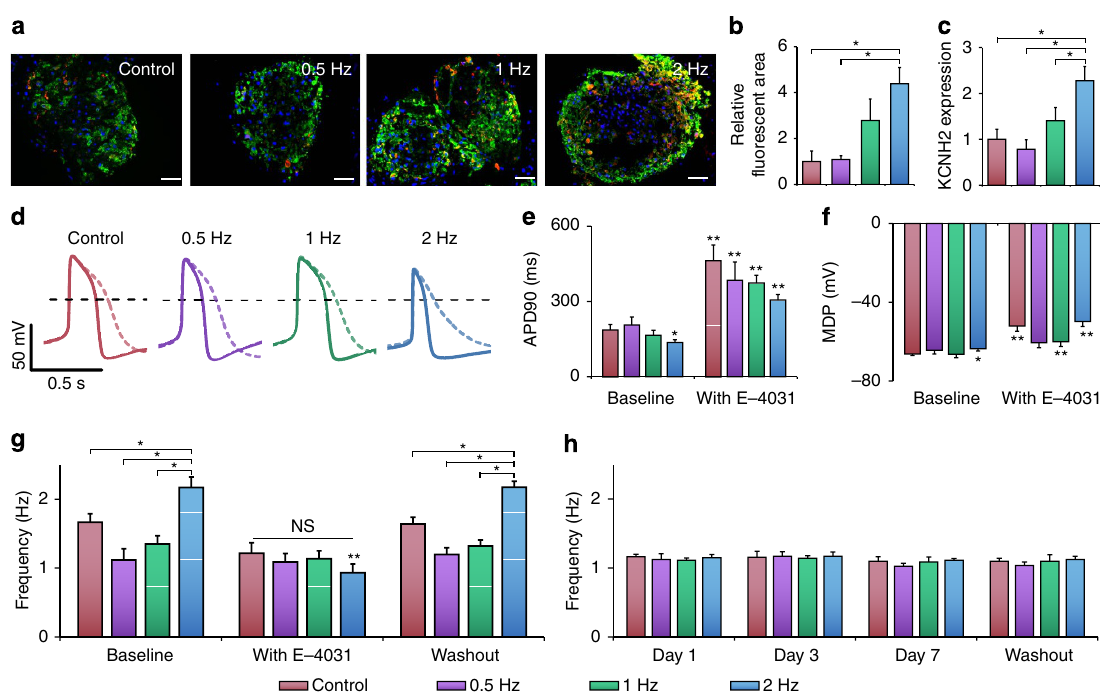
Figure 3 | Conditioning of the beating frequency by electrical stimulation is mediated by KCNH2 . ( a , b ) Immunostains of troponin (green) and hERG (red), counterstained with 4,6-diamidino-2-phenylindole (DAPI, blue); scale bar, 50 m m. Frequency-dependent increases in Troponin and hERG ( n ¼ 3, P o 0.05, one-way ANOVA with post hoc Tukey test). ( c ) qPCR of KCNH2 confirms the upregulation with stimulation (average ± s.e.m. of fold change). *Statistically significant differences between the 2-Hz group and the 1-, 0.5-Hz and control groups ( n ¼ 3, P o 0.05, one-way ANOVA with post hoc Tukey test). ( d ) Representative action potentials at baseline (solid) and after addition of the KCNH2 inhibitor E-4031 (dashed). The dashed black line represents 0mV. ( e , f ) Action potential duration (APD90) and maximum diastolic potential at baseline and when exposed to E-4031. *Significant difference